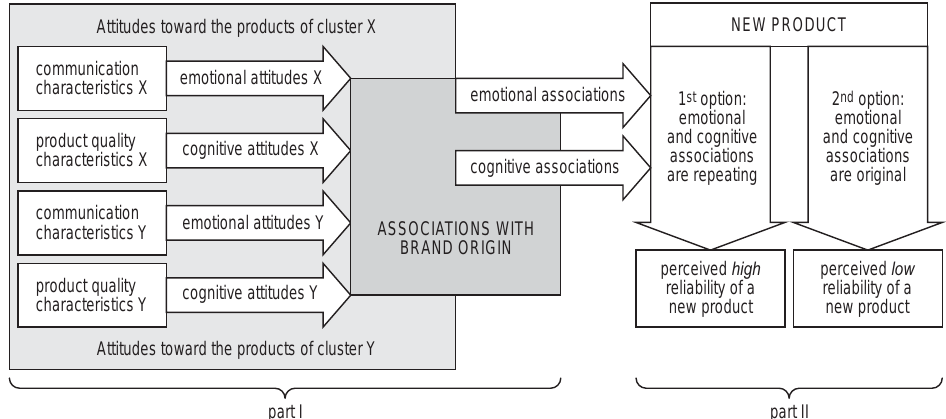
part I part Fig. 1. A model of the effect of communication on consumers’ perception towards brand origin and new product